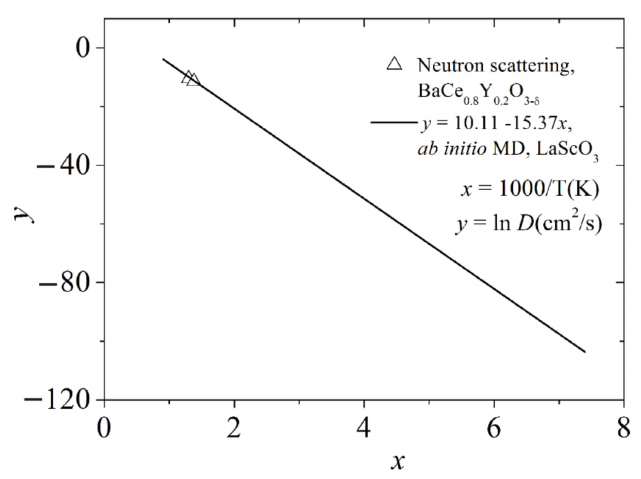
Figure 10. Dependence of ln D on the parameter 1000/ T at a constant weighted average activation energy E a = 1.255 eV for the movement of a proton along defect-free perovskite LaScO 3 ; also pre- sented here are the values of a similar characteristic for BaCeO 3 doped with yttrium obtained in the experiment on neutron scattering